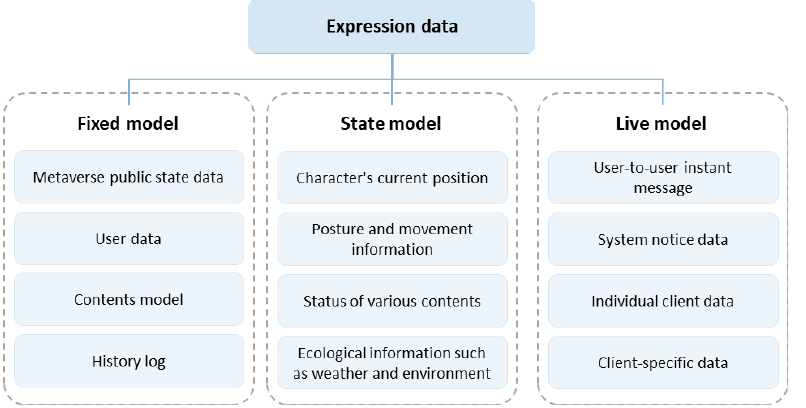
Figure 6. Expression data model.